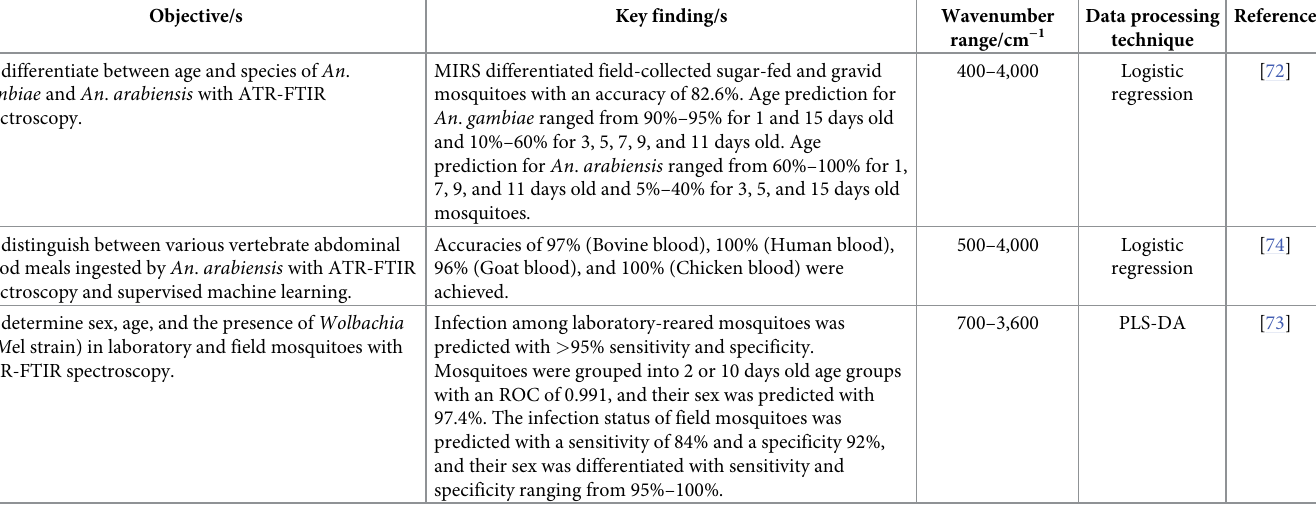
ATR, attenuated total reflectance; FTIR, Fourier transform infrared; MIRS, mid-infrared spectroscopy; PLS-DA, partial least squares-discriminant analysis; ROC, receiver operation